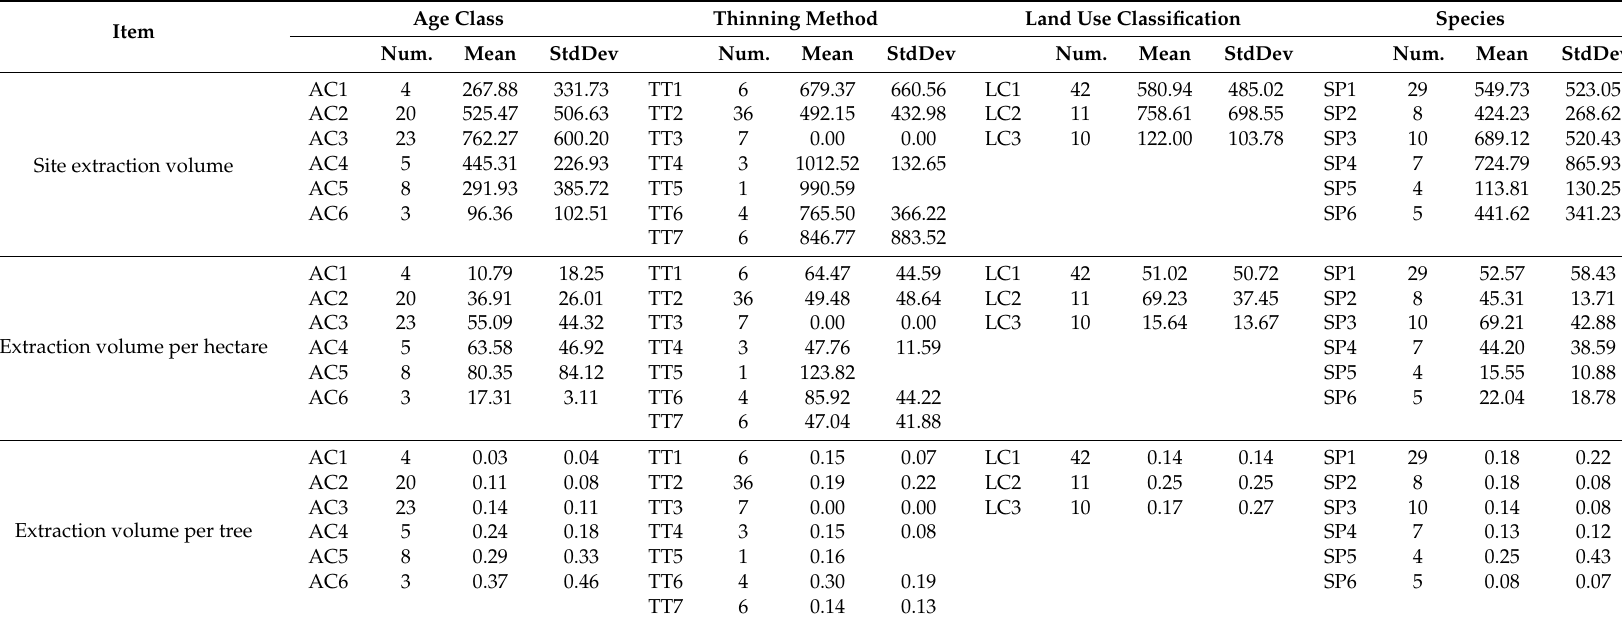
Table 5. Relationships between site/species attributes and extraction